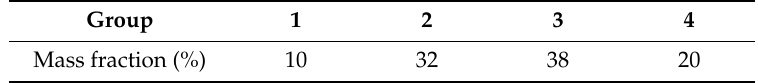
Table 4. Parameters for the simulation.